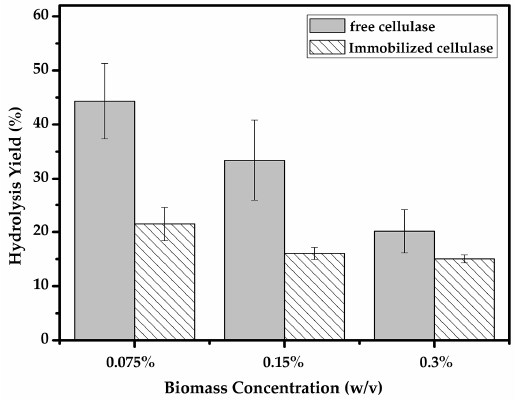
Figure 9. The hydrolysis of pretreated biomass using free and immobilized cellulase.